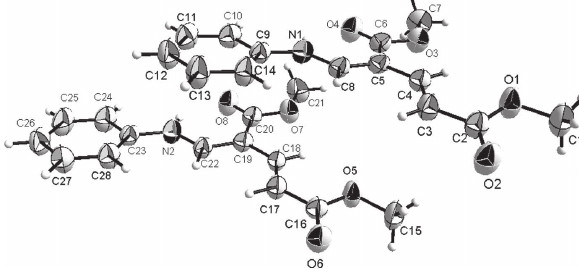
Table 1: Data collection and